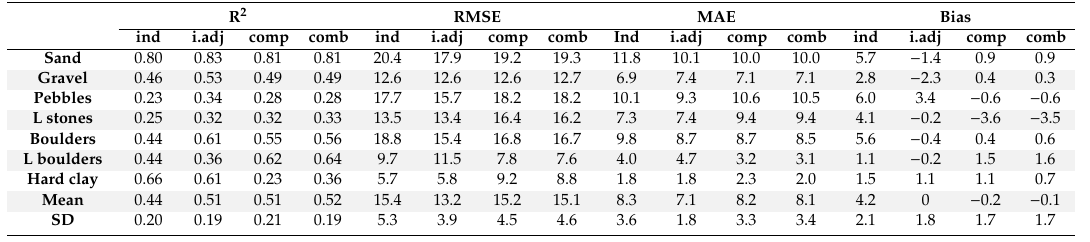
Table A2. Substrate component accuracy assessment using the validation data set (n = 154) for four model types, individual models (ind), individual models adjusted to 100% sum (i.adj), compositional models (comp), and combined compositional and individual models (hard clay component) adjusted to sum to 100% (comb). All models were run using Gaussian distribution boosted regression tree models with the same training data and predictor variables.